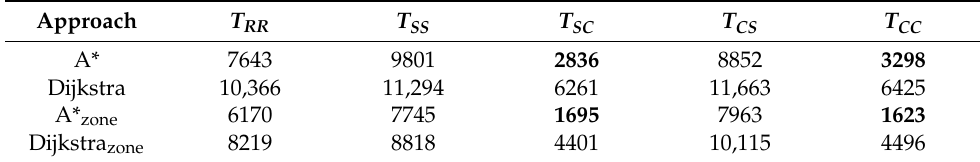
Table 2. The number of expanded cells normalized to the path